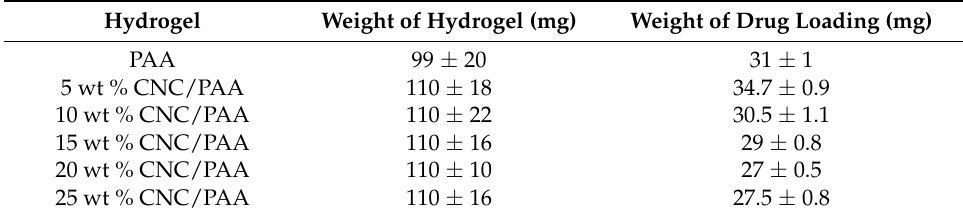
Table 3. Data of drug loading by weight.